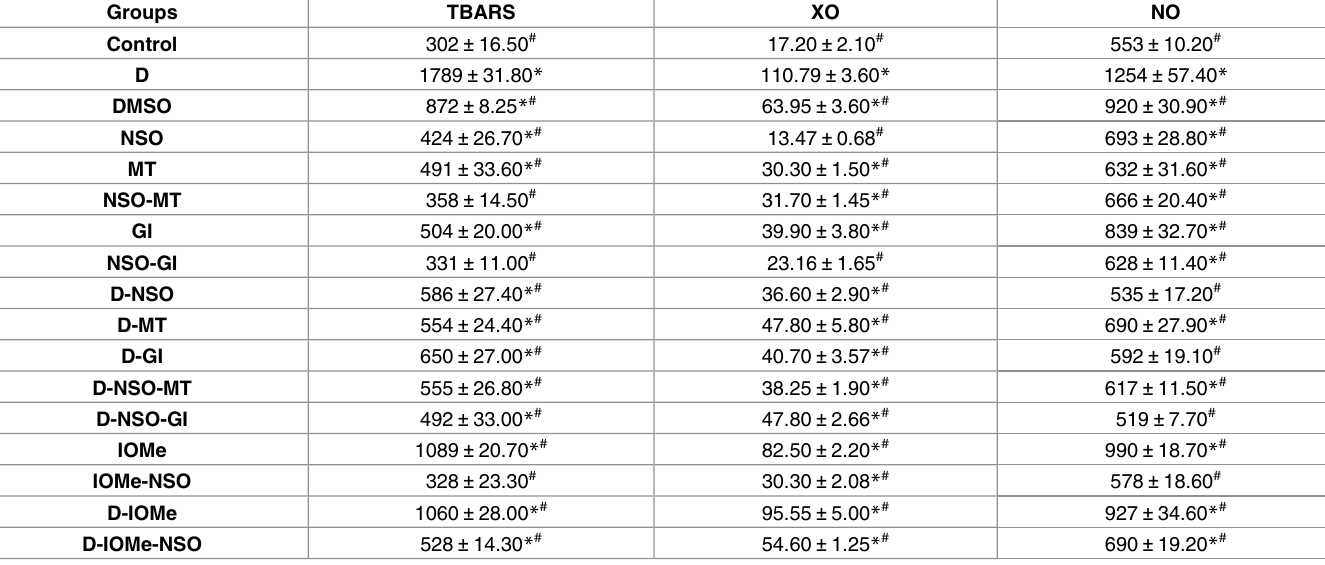
Table 2. Changes in oxidative stressparameters in diabetic rat brain after the course of treatment with NSO, antidiabetic drugs, combination ther- apy and I-OMeAG538. Groups